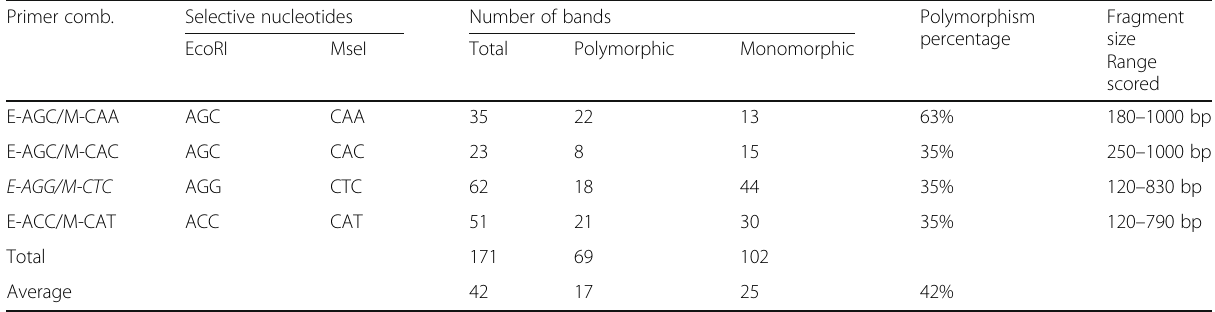
Table 4 The AFLP primer combinations, selective nucleotides, number of total bands polymorphic bands, and fragment size range for Thymus species Primer comb.